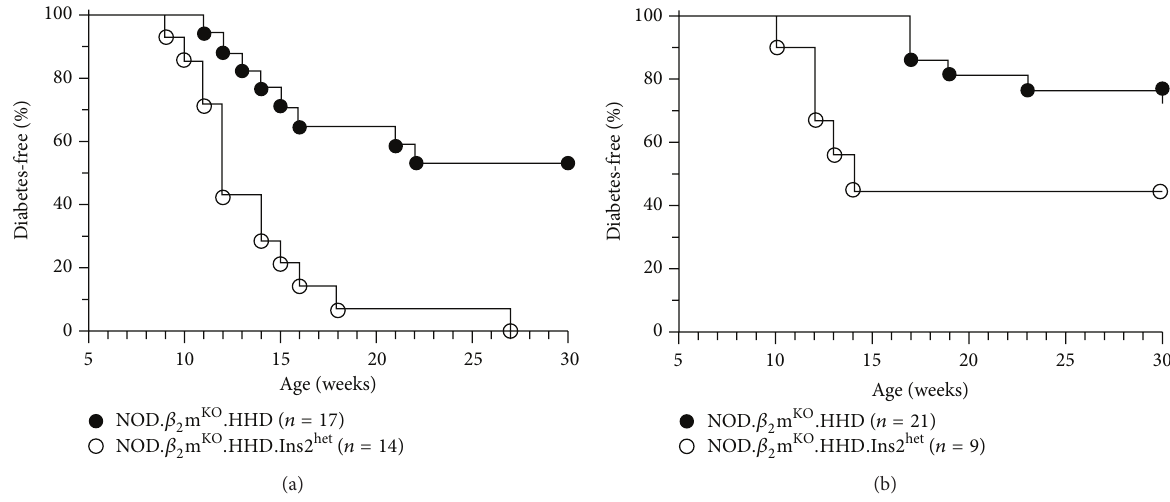
Figure 1: Diabetes development in NOD. 𝛽 2 m KO .HHD and NOD. 𝛽 2 m KO .HHD.Ins 2 het mice. (a) Female and (b) male NOD. 𝛽 2 m KO .HHD (filled circles) and NOD. 𝛽 2 m KO .HHD.Ins 2 het mice (open circles) were followed weekly for diabetes development. (a) 𝑝 = 0.0002 , Mantel- Cox. (b) 𝑝 = 0.04 ,